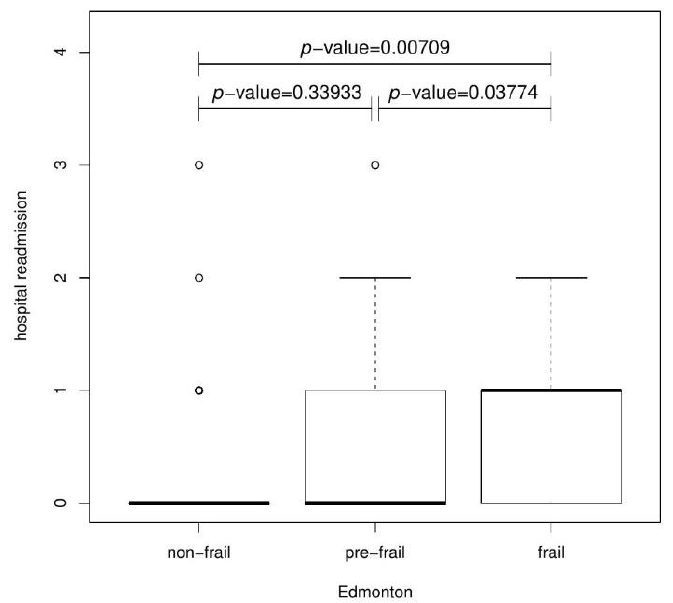
Figure 6. Boxplot presenting the relationship p between Hospital readmission and Edmonton after 6 months.